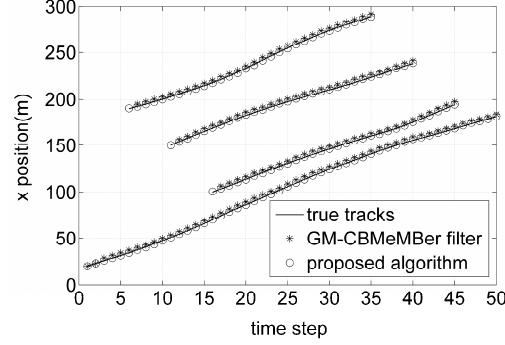
Figure 3. True target tracks and position estimations in x coordinate versus time.